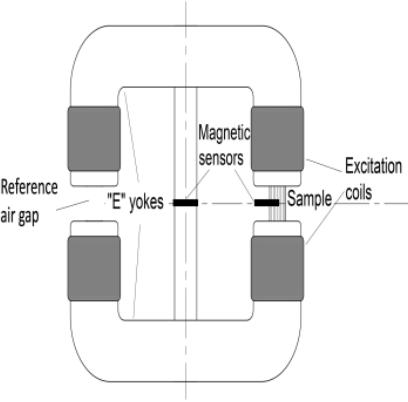
Figure 2. The setup of the applied Stablein-Steinitz DC magnetometer.